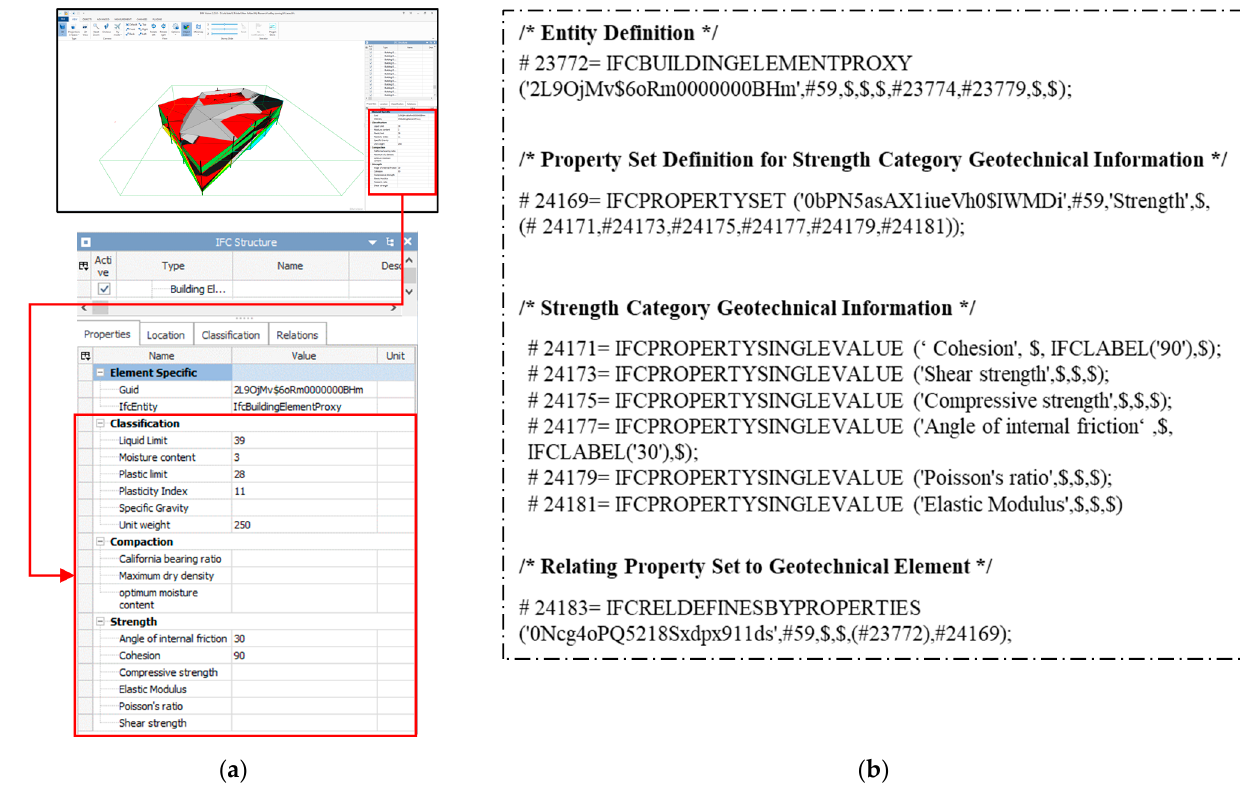
Figure 9. ( a ) Visualization of IFC-based geotechnical property model in open BIM tool; and ( b ) Part of EXPRESS code showing the strength category information stored in the IFC format.